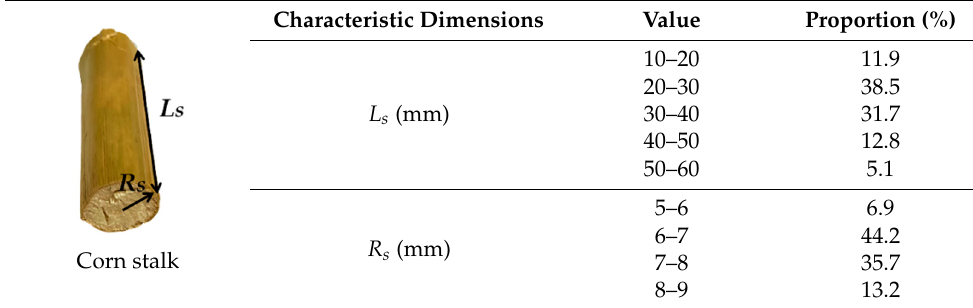
Table 6. Characteristic dimensions of corn stalks.